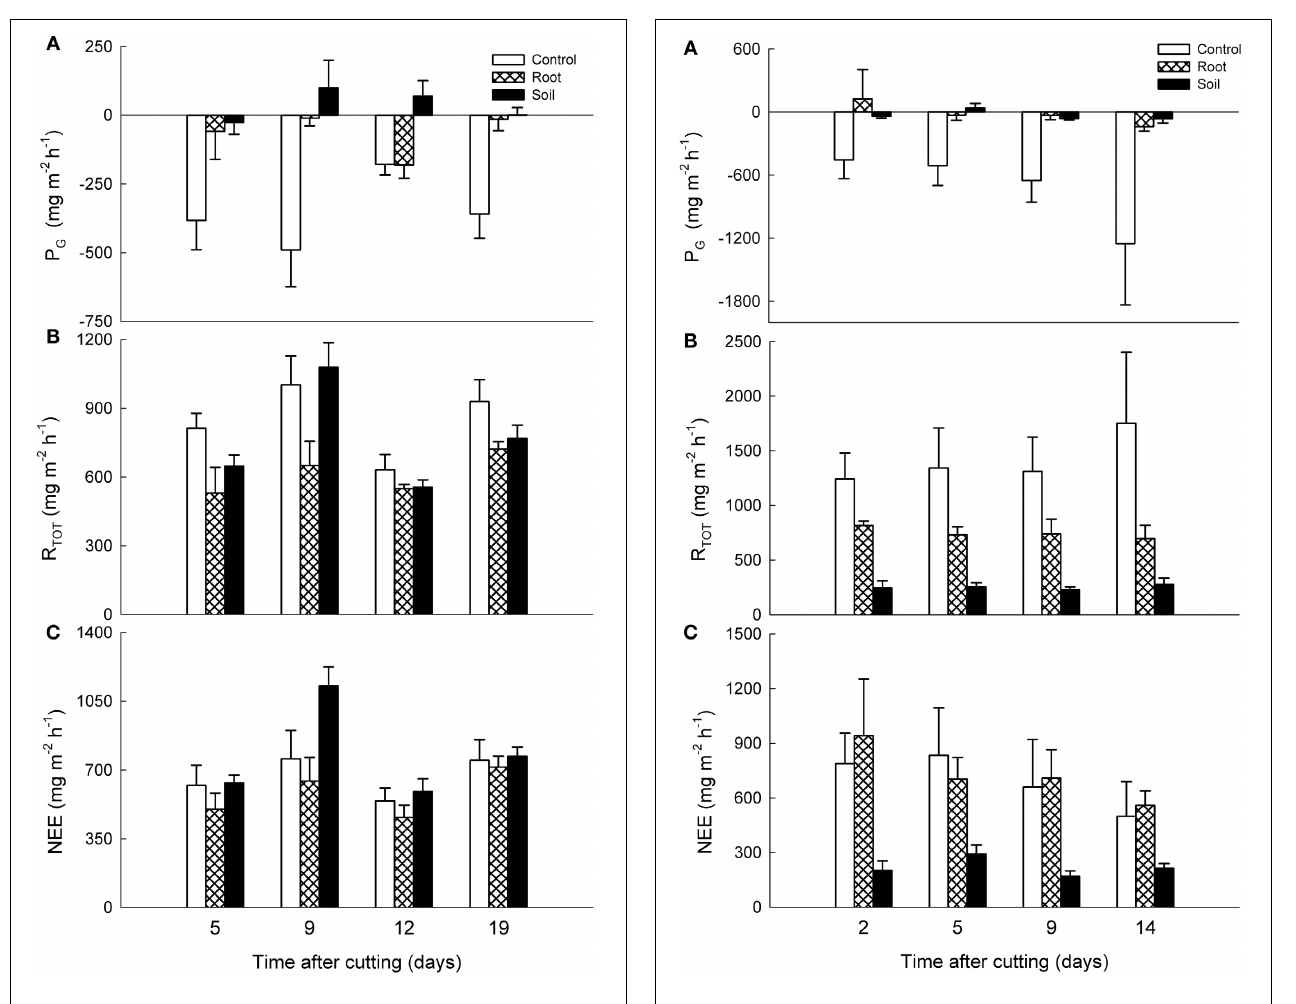
FIGURE 4 | Effects of experimental manipulations on CO 2 exchange in mixed heath mesocosms. Mean ( + SE, n = 3) (A) gross photosynthesis (P G ), (B) dark ecosystem respiration (R TOT ) and (C) net ecosystem exchange (NEE) with intact vegetation (control), cut aboveground vegetation (root mesocosms), and all vegetation removed (soil mesocosms) as function of time after cutting. Positive values denote carbon loss and negative values carbon uptake into the system.